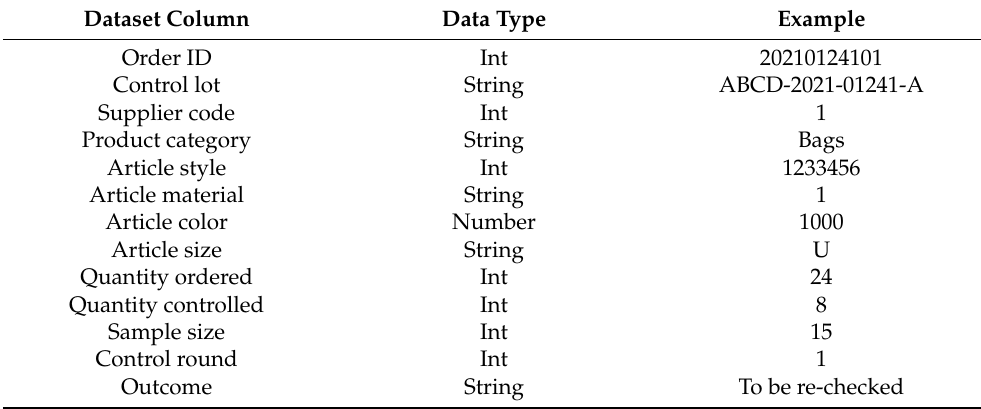
Table 1. Control dataset